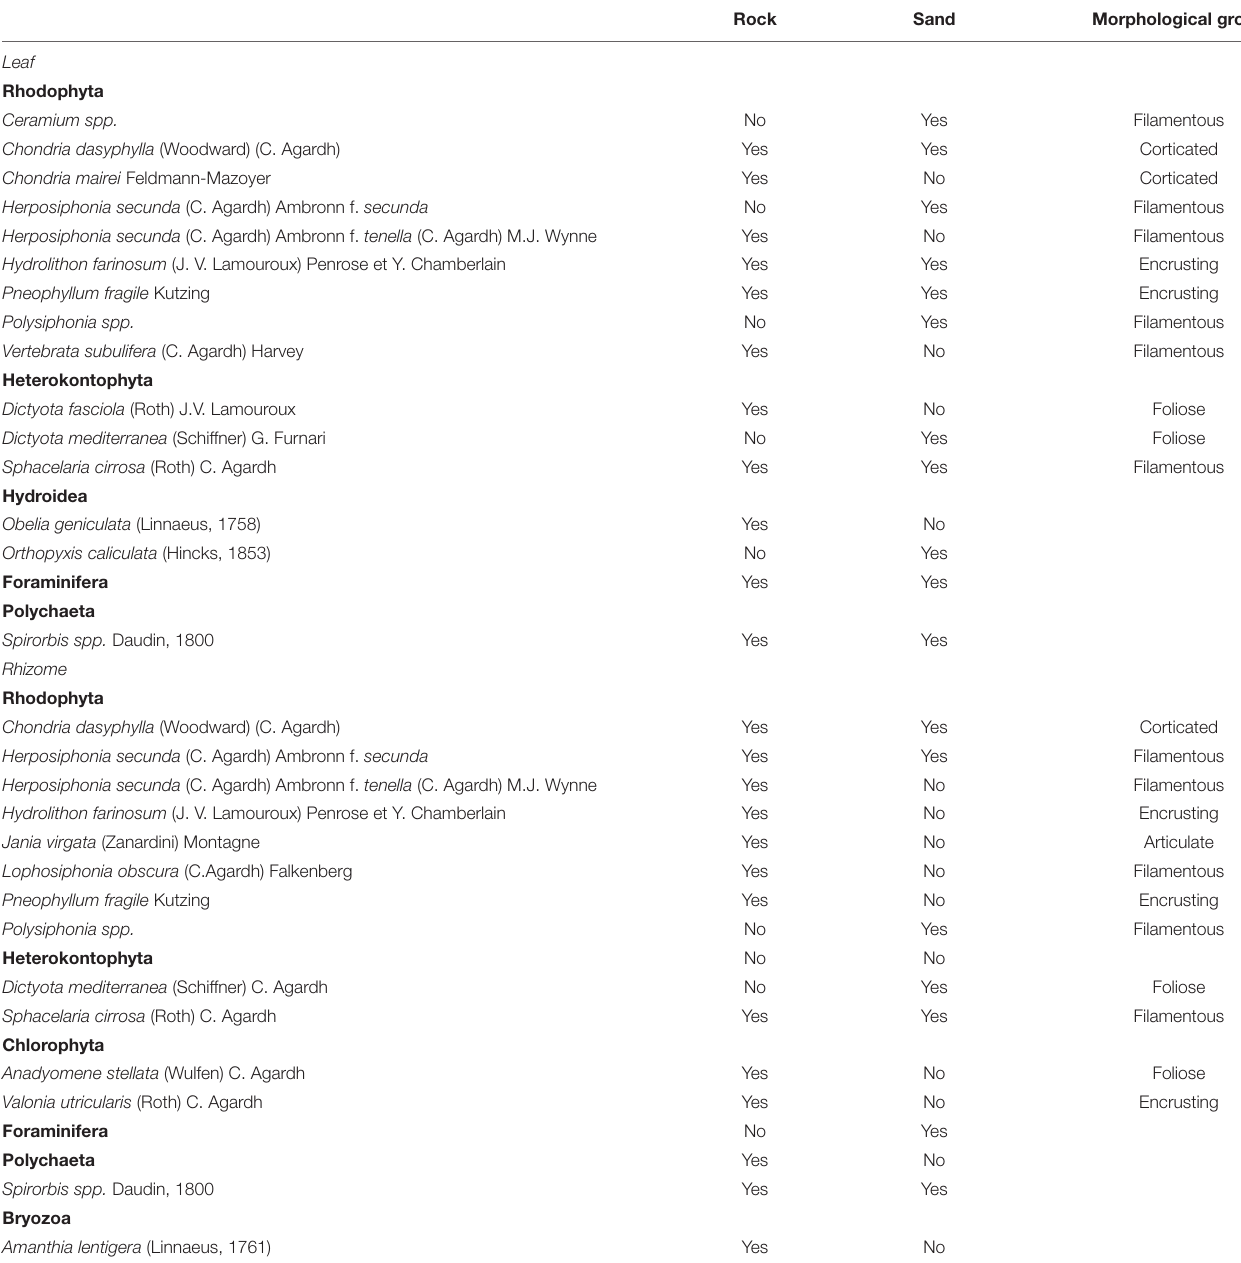
TABLE 1 | Species and taxa found on leaves and rhizomes of five-year old Posidonia oceanica seedlings growing on rock or sand substrate. Rock Sand Morphological